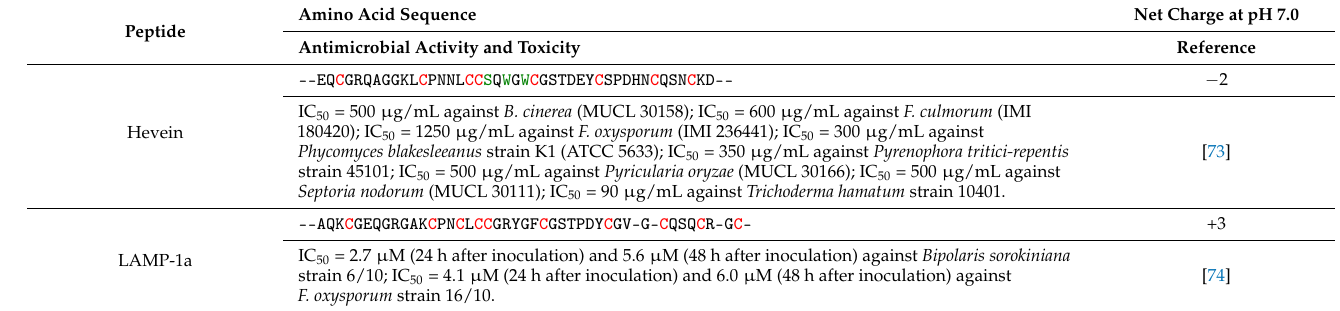
Table 2. Hevein, hevein-like peptides, and derived peptides: sequence, net charge at pH 7.0, and biological activity. Cysteine residues are shown in red, and substituted amino acids are highlighted in cyan. Amino acids involved in chitin-binding are shown in green. Gaps ( − ) were introduced to improve the